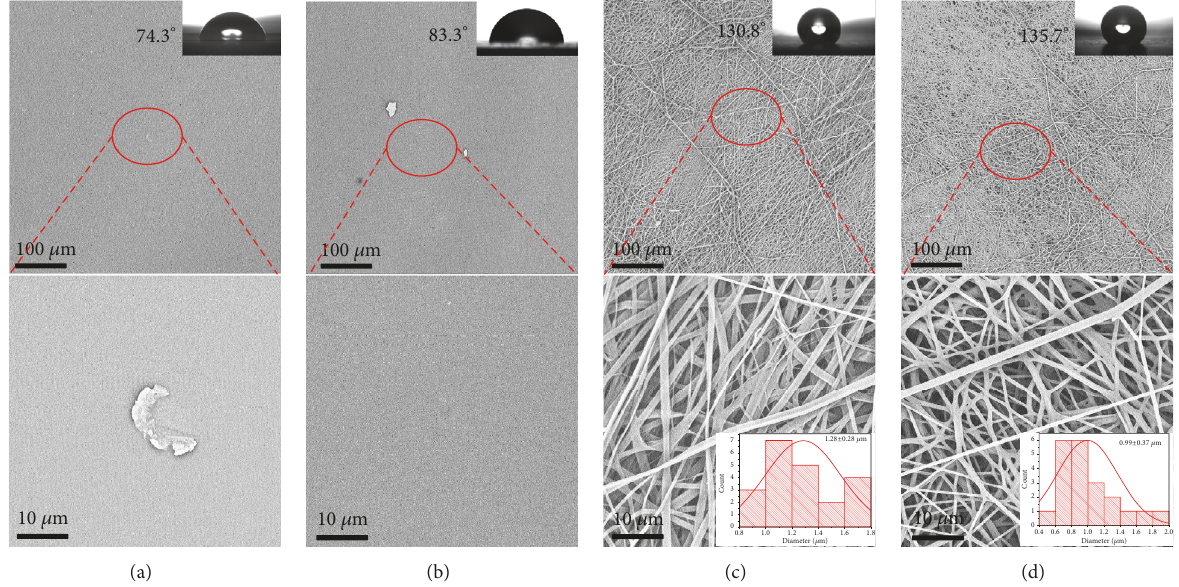
Figure 2: SEM images of the PVB films made by spin-coating 250 r/s (a), bar-coating 6 𝜇 m (b), positive electrospinning 15 cm (c), and negative electrospinning 15 cm (d). The upper inset images showed the water droplet onto these films, and the lower inset images showed the electrospun fiber diameter